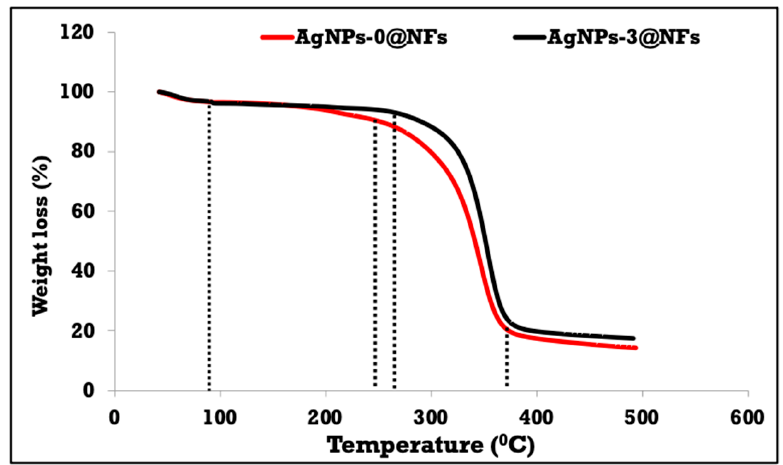
Figure 8. TGA of nanofibrous sheets with and without AgNPs; AgNPs-0@NFs and AgNPs-3@NFs.